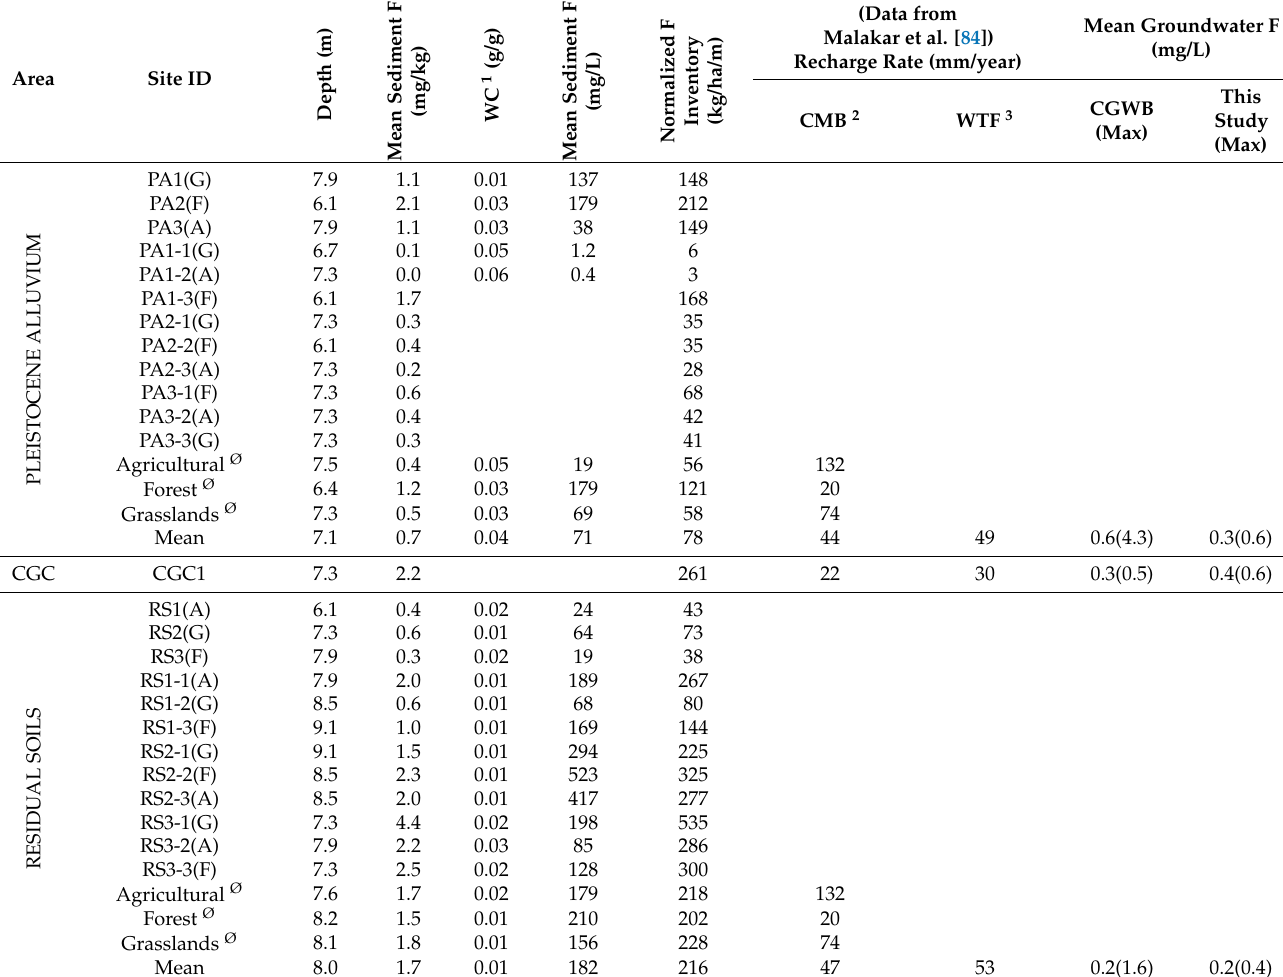
Table 2. Comparison of unsaturated zone F and groundwater F concentration in the three drilling sites; letters in the parenthesis under Site ID denote G—Grasslands, A—Agricultural lands, and F—Forests; Ø denotes